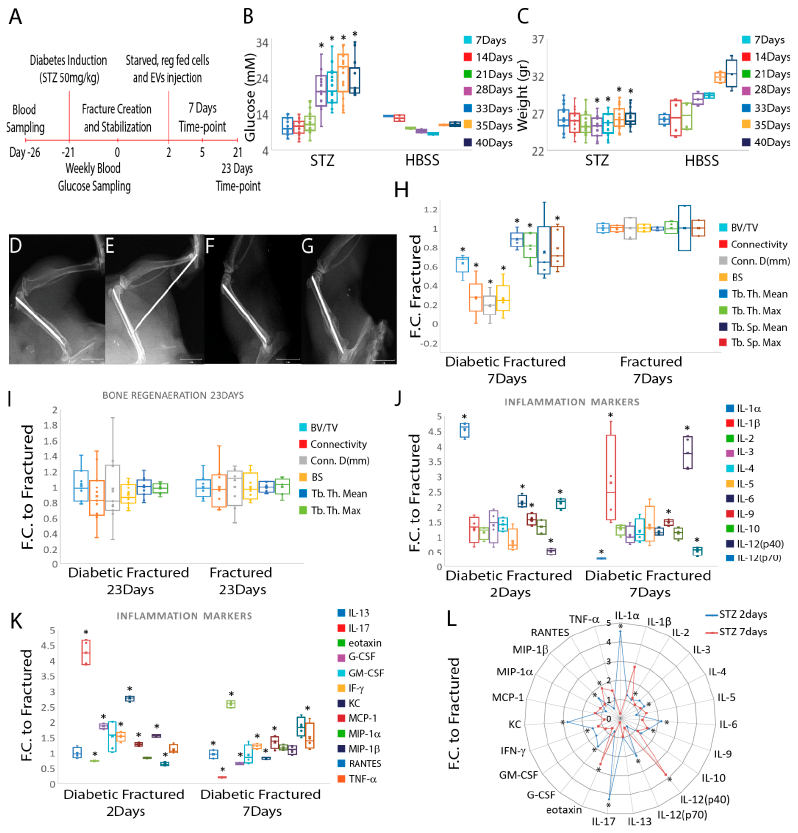
Figure 4. In vivo approach summary and comparison of regenerative and inflammatory cytokine expression in diabetic and non-diabetic mice at two and seven days post fracture. ( A ) In vivo exper- imental plan employed in this study. ( B ) Diabetes was successfully induced with STZ compared to control mice. The data are presented as mean ± SD. * p ≤ 0.05 (sample size four to sixteen ani- mals/group, Student’s t -test and paired t -test). ( C ) The bodyweight of diabetic mice was consistently lower than that of control animals. The data are shown as mean ± SD. * p ≤ 0.05 (sample size four to sixteen animals/group, Student’s t -test and paired t -test). (D–G) X-ray scans of the mouse femur immediately after fracture ( D ), after two days ( E ), which directed the approach for treatment into the fracture site, and after seven ( F ) and 23 days ( G ). ( H ) μ CT quantitative analysis of diabetic mice fracture revealed a decreased mineral matrix content when compared to untreated animals at the seventh day time-point. The data are normalized to non-diabetic fractured animals and are pre- sented as mean fold change ± SD. p ≤ 0.05 * respect to EVs, +Cells. ( I ) No difference was seen between the diabetic and non-diabetic animals at the 23rd day time-point for any one of the analyzed µ CT parameters. The data are normalized to non-diabetic fractured animals and are presented as mean fold change ± SD (sample size four to six animals/group, one-way ANOVA followed by Fisher’s post hoc test). ( J – K ) Comparison of inflammatory cytokine expression in diabetic and non-diabetic mice at two and seven days post fracture with respect to fractured animals. ( L ) Comparison of inflammatory cytokine expression in diabetic fractured mice at two and seven days. The data are normalized to non-diabetic fractured animals and are presented as mean fold change ± SD. * p ≤ 0.05 (sample size four animals/group, Student’s t -test and paired t -test). Scale bar: 1 mm. Abbreviations: streptozotocin (STZ); extracellular vesicles (EVs); fold change (F.C.); bone volume/total volume, (BV/TV); connectivity density, (Conn.D (mm − 3 )); bone surface, (BS(mm 2 )); trabecular thickness mean, (Tb. Th. Mean (mm)); trabecular thickness max, (Tb. Th. Max (mm)); trabecular spacing mean, (Tb. Sp. Mean (mm)); trabecular spacing max, (Tb. Sp. Max